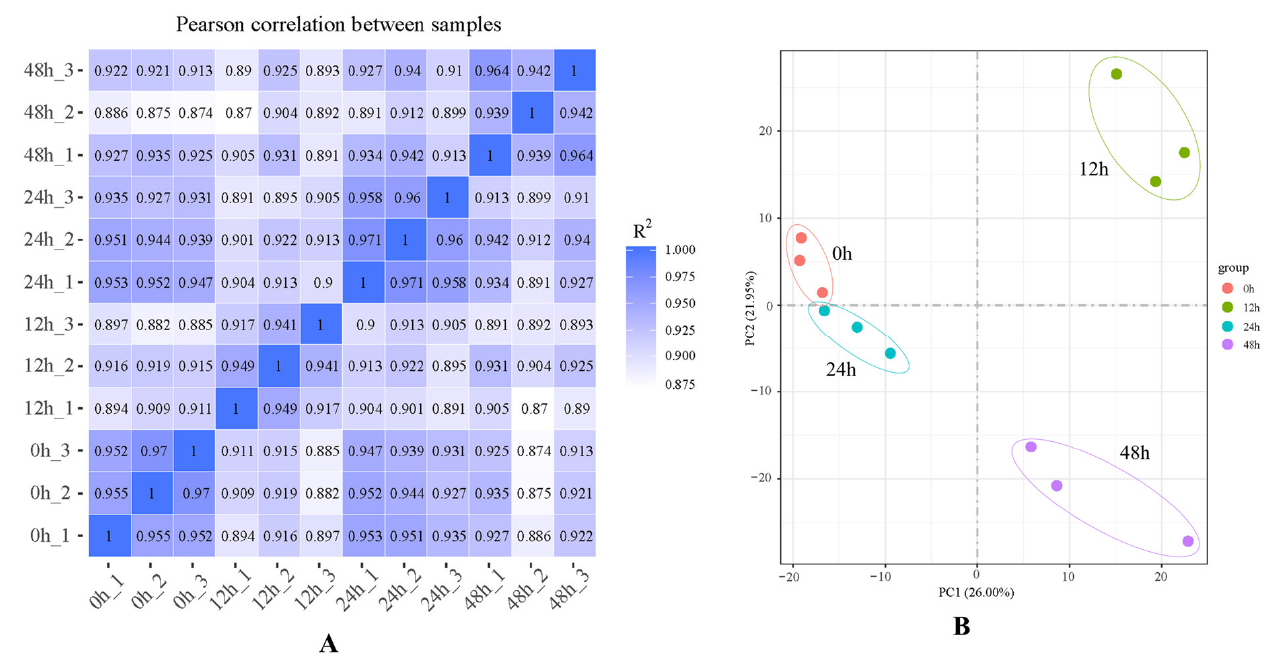
Figure 2. Correlation analysis and principal component analysis (PCA): ( A ) sample correlation analysis; ( B ) sample distributions in PCA 1 and PCA 2.